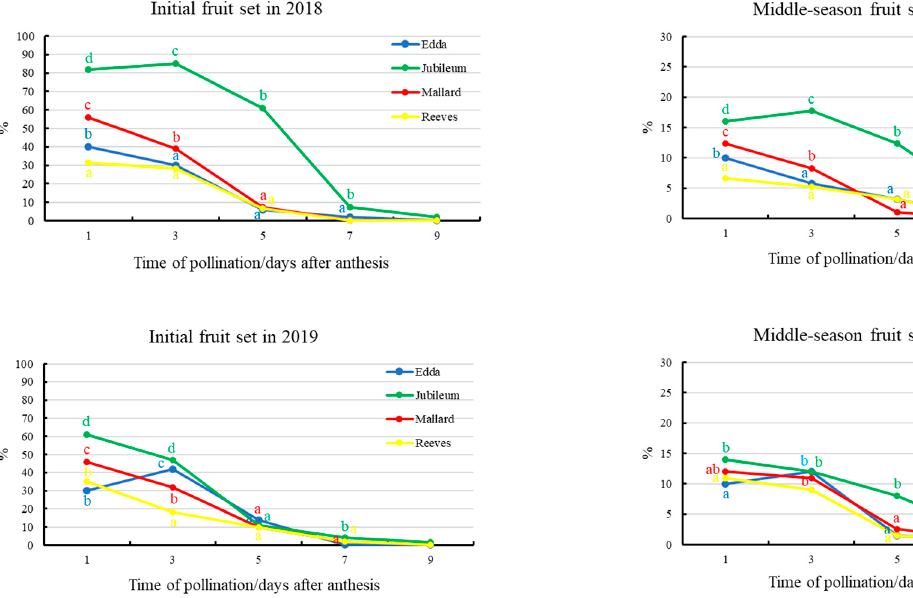
Figure 4. Initial (IFS), middle-season (MFS) and final fruit set (FFS) of four plum cultivars during 2018 and 2019 (different small letters in the same column denote a significant difference between the cultivars according to LSD test, p < 0.05).